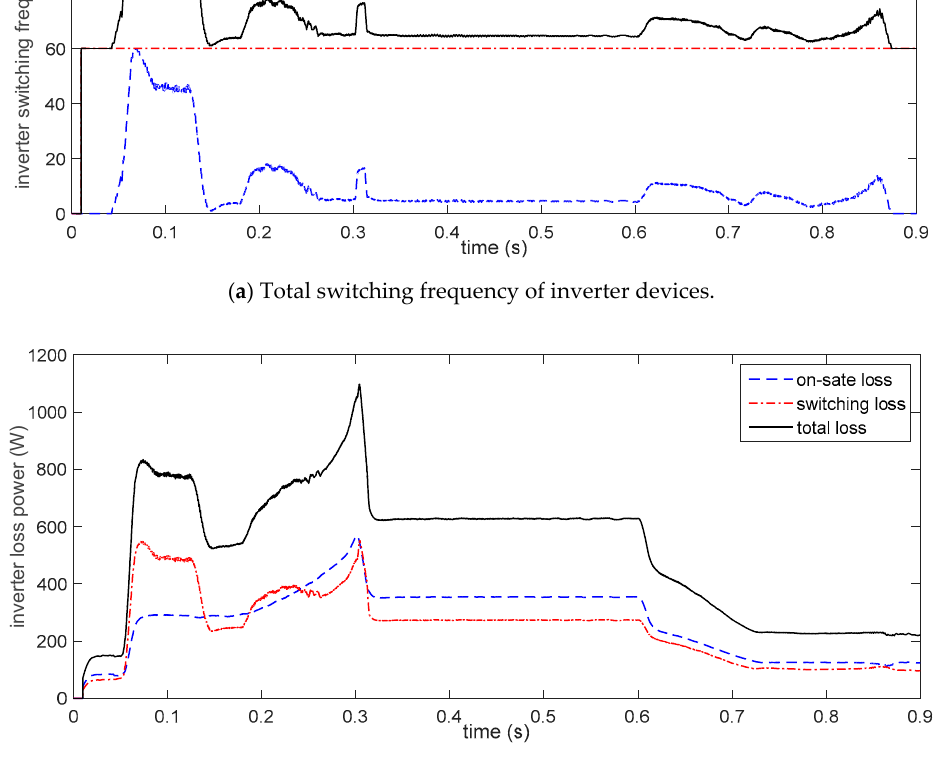
Figure 17. Curves of inverter switching frequency and inverter loss power.